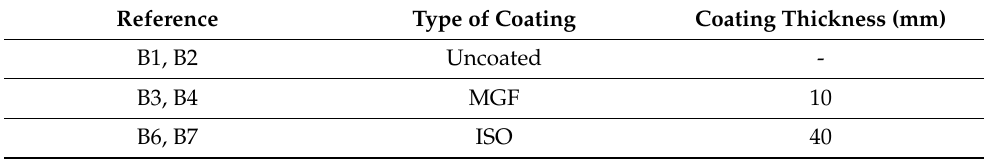
Table 2. Summary of wall test